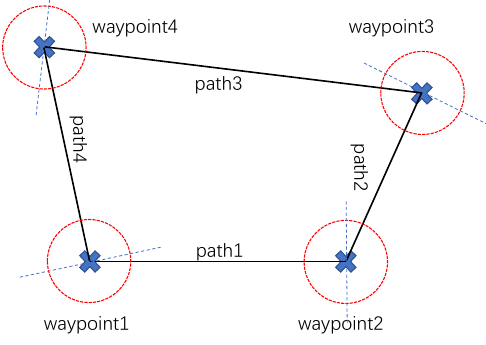
Figure 6. Waypoints and